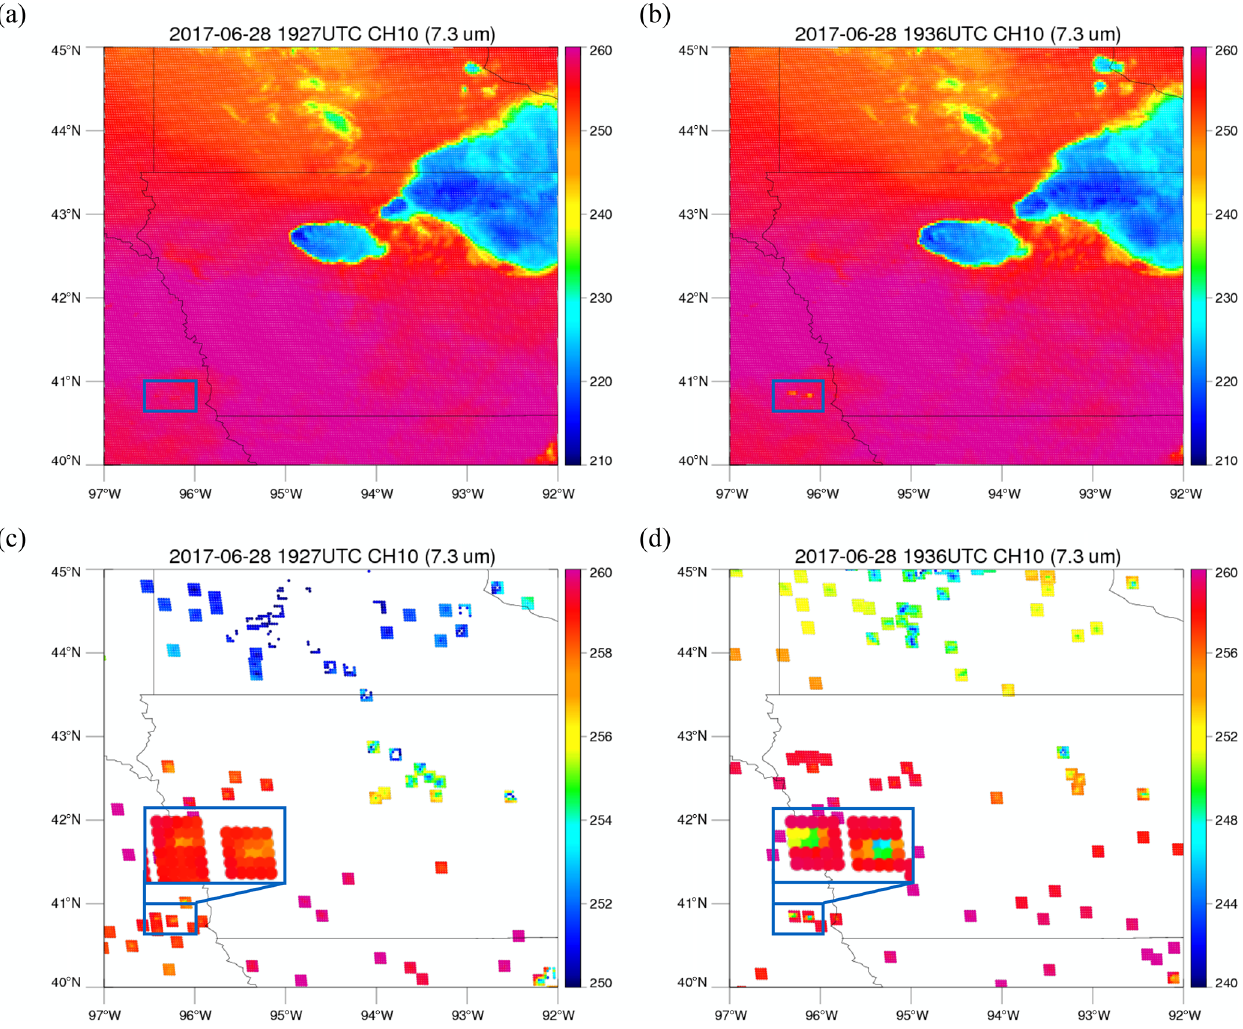
Figure 4. (a) GOES-ABI 7.3µm infrared channel imagery (K) at 19:27UTC on 28 June 2017. Blue box denotes regions where two convective clouds start to grow. (b) Same as (a) , but at 19:36UTC. (c) T b matrices obtained from Channel 10 (7.3µm) that have the Gaussian shape at 19:27UTC on 28 June 2017. Blue box denotes the same region as the blue box in (a) . Note that the scale of the color bar is adjusted from (a,b) to better observe convective initiation. (d) Same as (c) , but at 19:36UTC.